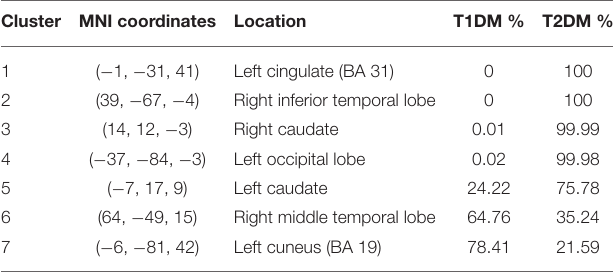
TABLE 3 | ALE clusters of lower gray matter volumes in T1DM and T2DM compared to controls. Cluster MNI coordinates